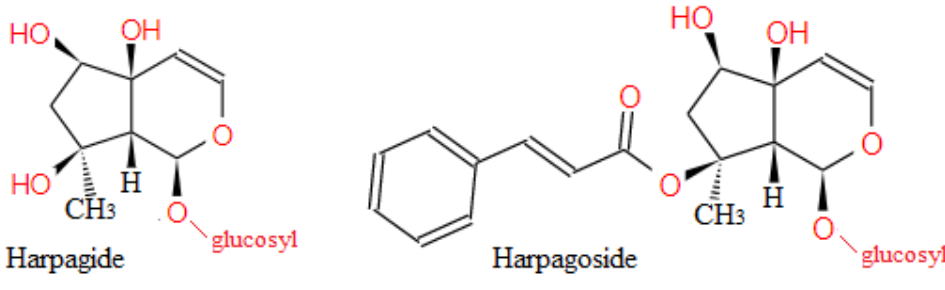
Fig. 1. Main BAS of Harpagophytum